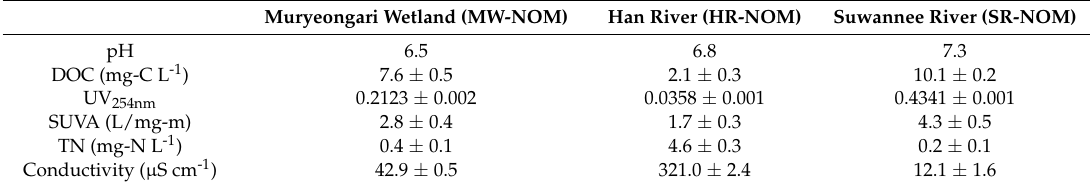
Table 3. Water characteristics of various types of natural organic matter.